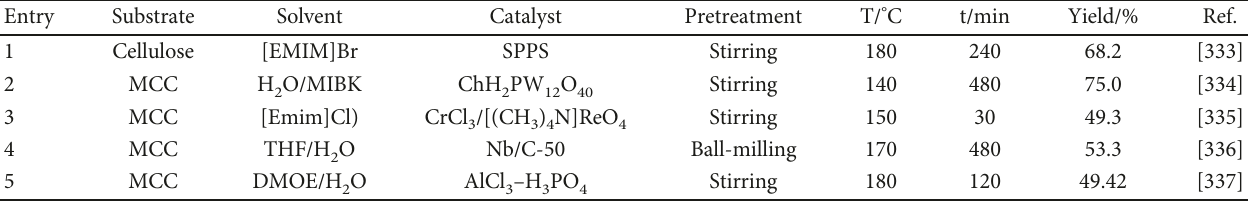
Table 5: Overview of 5-HMF yields from the conversion of cellulose in the typical catalytic